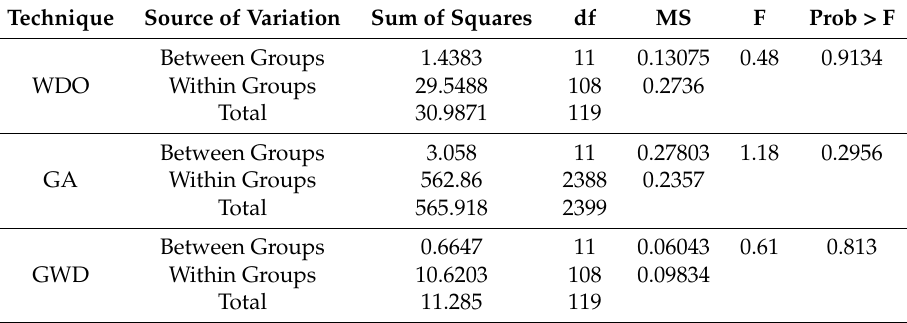
Table 16. ANOVA results for the proposed algorithm with the existing